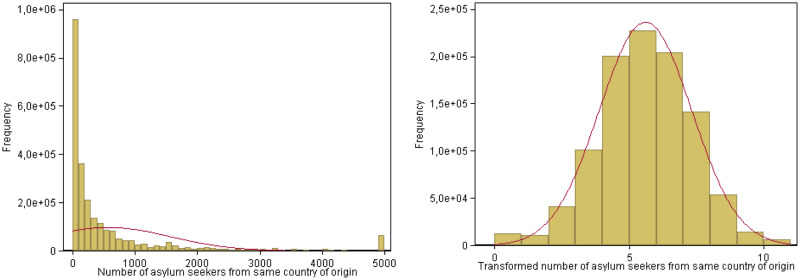
Transformed and untransformed asylum network histogram.Panel A: Untransformed network measure. Panel B: Transformed network measure. Source: [13], own calculations. Notes: In Panel A, the x-axis measures the numbers of co-national asylum seekers from the same county of origin residing in the same county, while in Panel B it refers to the inverse hyperbolic sine of the same measure. The bandwidths are set to 100 in Panel A and 1 in Panel B. In both figures, the y-axis indicates the respective frequencies, and the red line represents a normal distribution with the same mean and standard deviation.